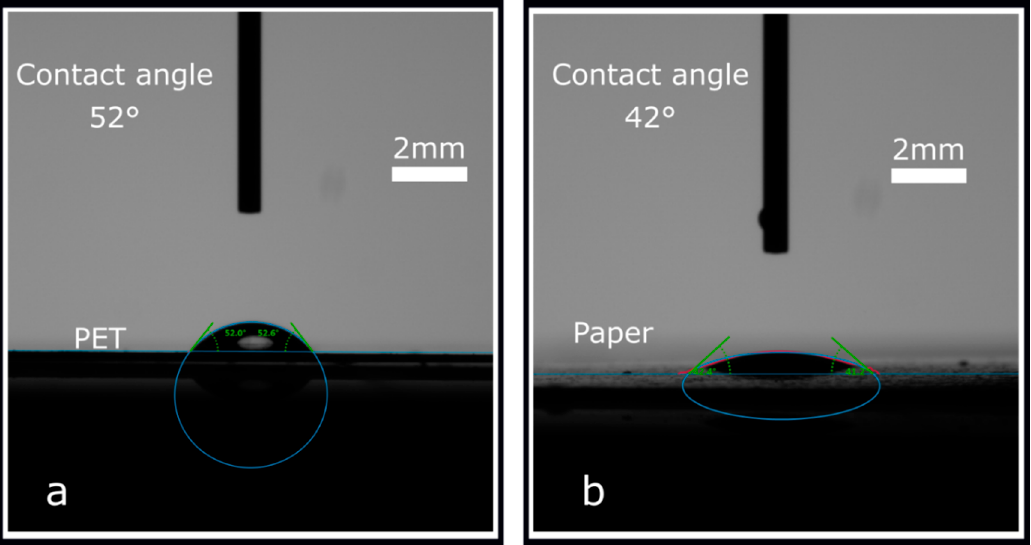
Figure A4. Water contact angle on ( a ) polyethylene terephthalate substrate (PET) and ( b ) paper substrates.